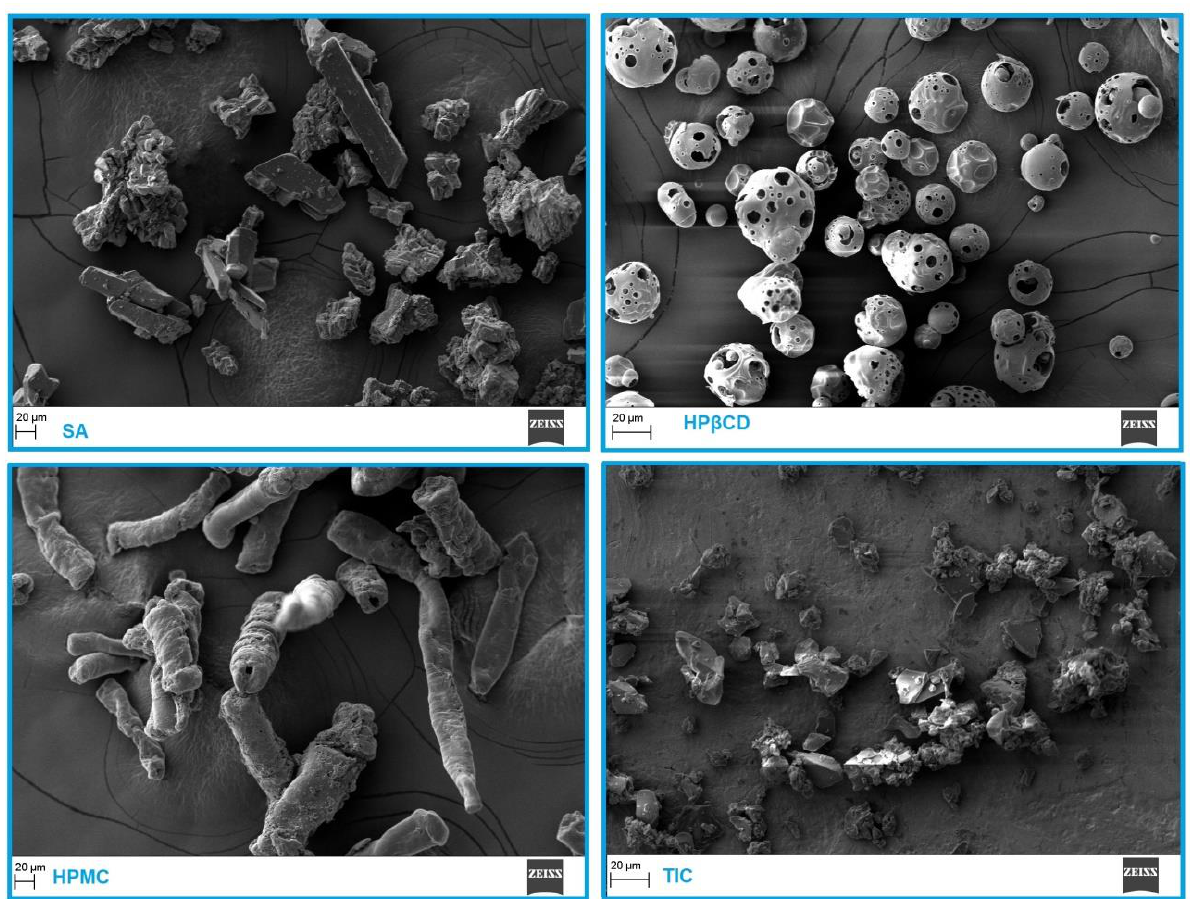
Figure 6. SEM graph of SA, HP β CD, HPMC, and TIC.